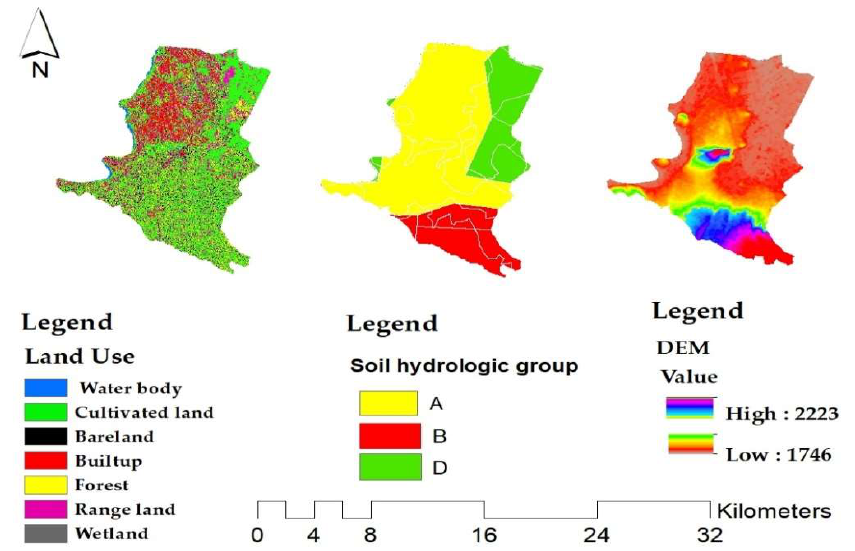
Figure 7. The land use map, soil hydrologic map and DEM of Hawassa City.